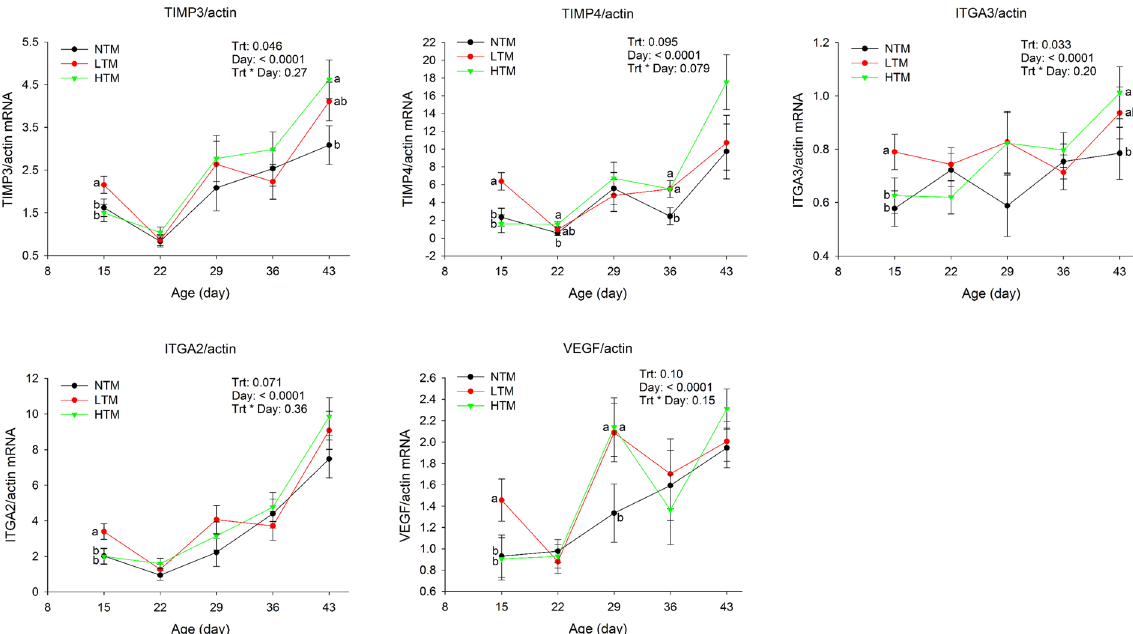
Figure 3. Gene expression of TIMP3, TIMP4, ITGA3, ITGA2 and VEGF fed three levels of TM. There was no interaction between treatments and age, treatment differences in birds at same age were shown in the graphs. Means with different letters differ at P <